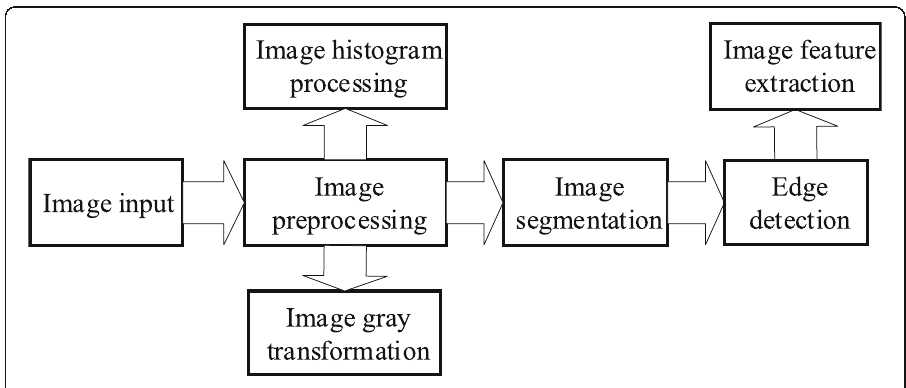
Fig. 2 Flow chart of image processing